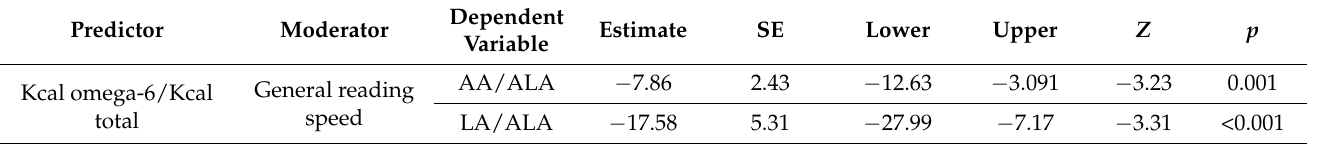
Figure 2. Mediation model with general reading speed (z-score) as the dependent variable, Kcal omega-6/Kcal total as the independent variable, and LA/ALA ratio as mediator (* p < 0.10, ** p < 0.05, one-tailed). The figure shows direct and indirect (component) effects. Betas are completely stand- ardized effect sizes. Table 6. Moderation models: analyses of the effect of learning measures (z-scores) in the associations of Kcal omega-6/Kcal total (predictor) with AA/ALA and LA/ALA ratios (dependent variables).